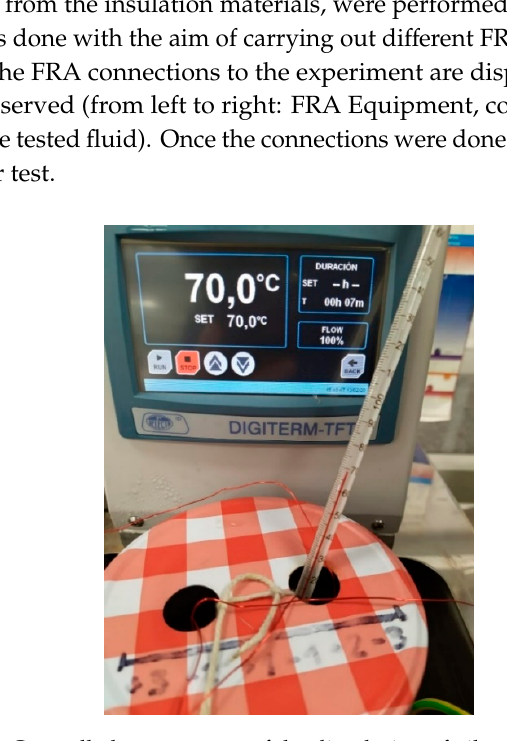
Figure 10. Controlled temperature of the dissolution of oil and water at 70 °C.